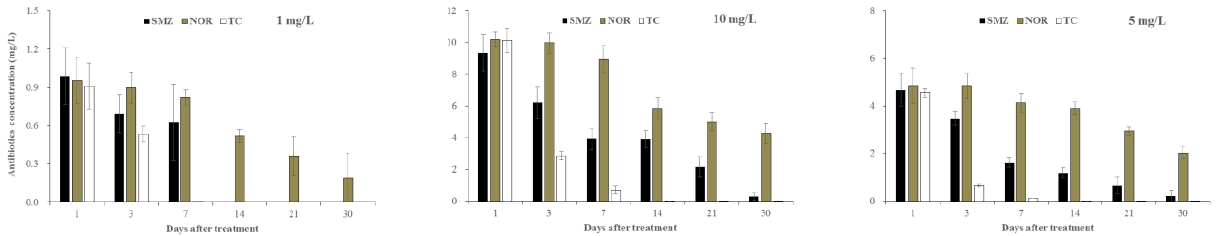
Figure 4. Selected antibiotic concentrations in hydroponic culture solution (parrot feather) under various treatments at the end of the experimental period.